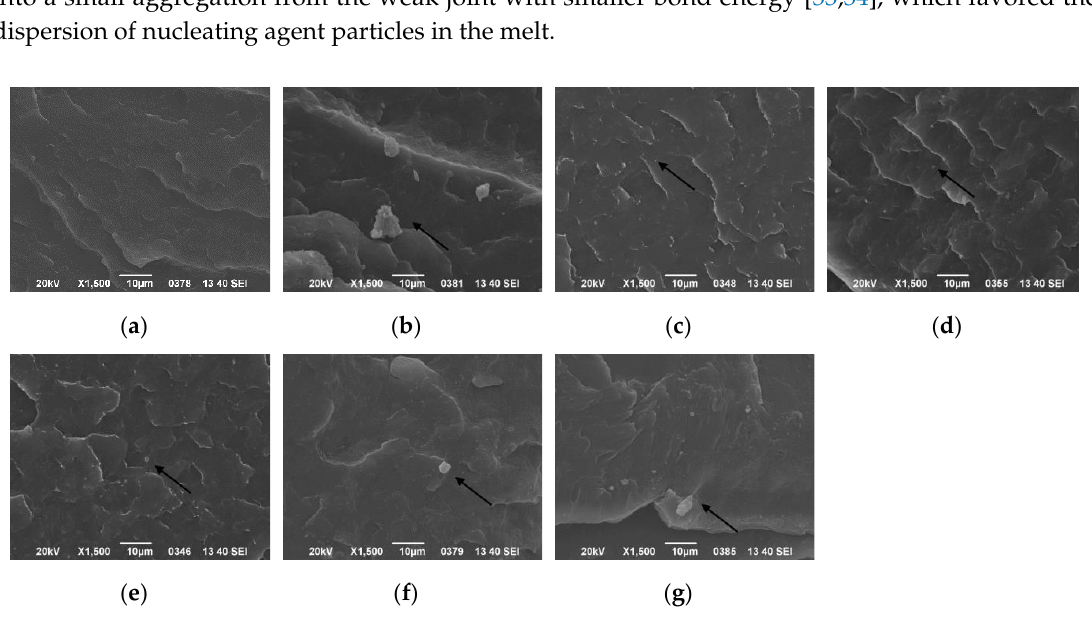
Figure 4. Effect of different ultrasound distances on dispersion of the nucleating agent in the PP matrix: ( a ) pure PP; ( b ) without ultrasound; ( c ) 1 cm; ( d ) 2 cm; ( e ) 3 cm; ( f ) 5 cm; ( g ) 7 cm.